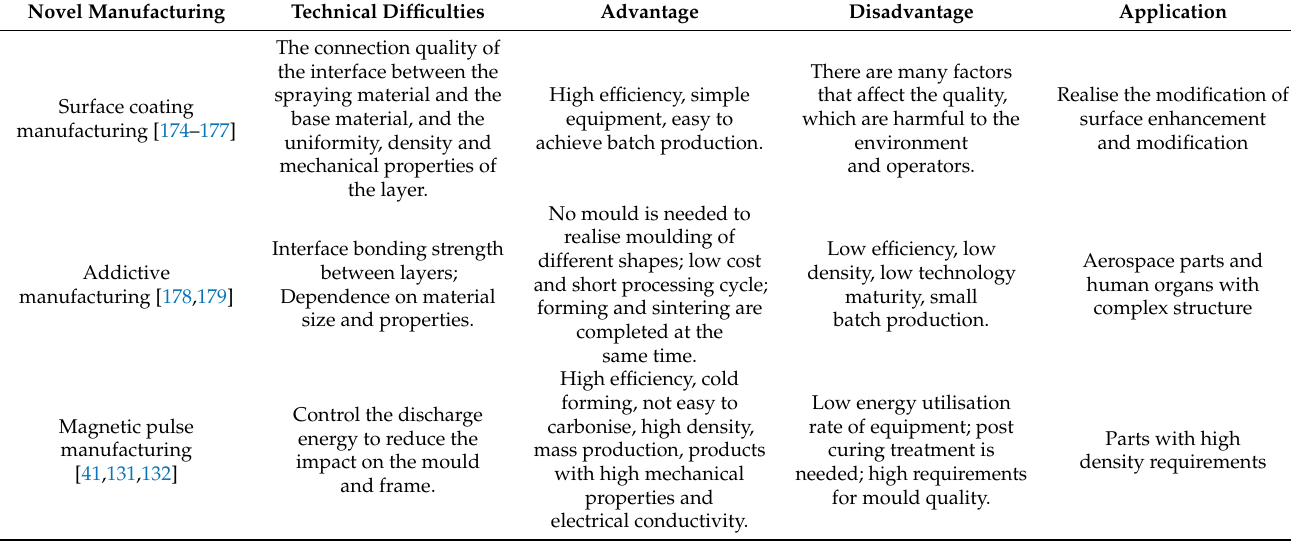
Table 7. Novel manufacturing technology for polymer